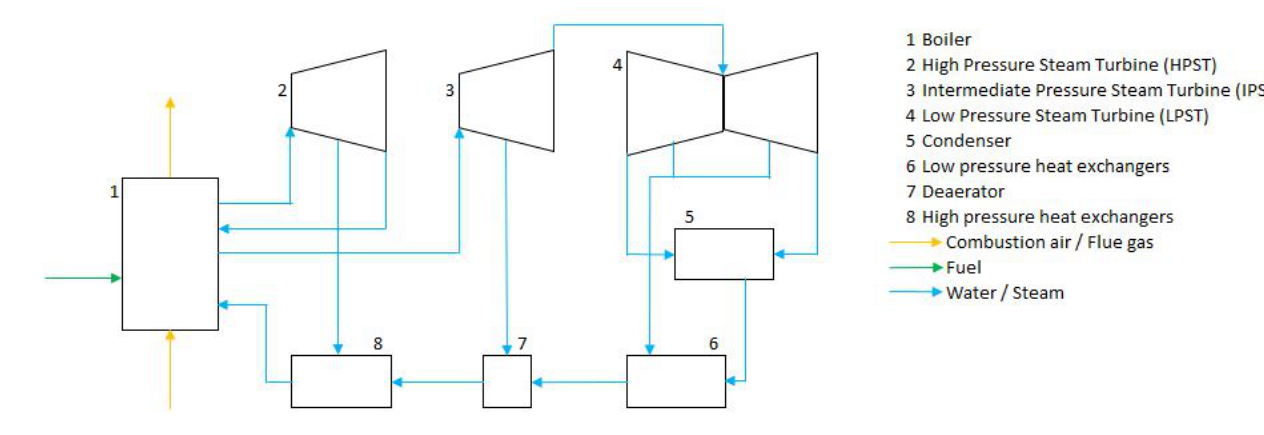
Figure 2. Simplified schematic of the steam